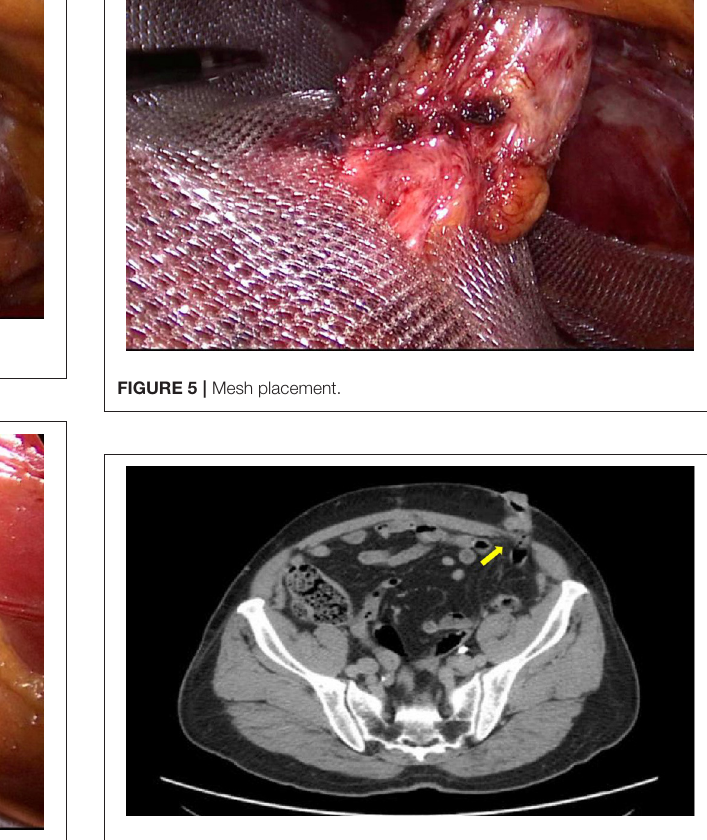
FIGURE 6 | Post-operative CT image showing no recurrence of hernia (yellow